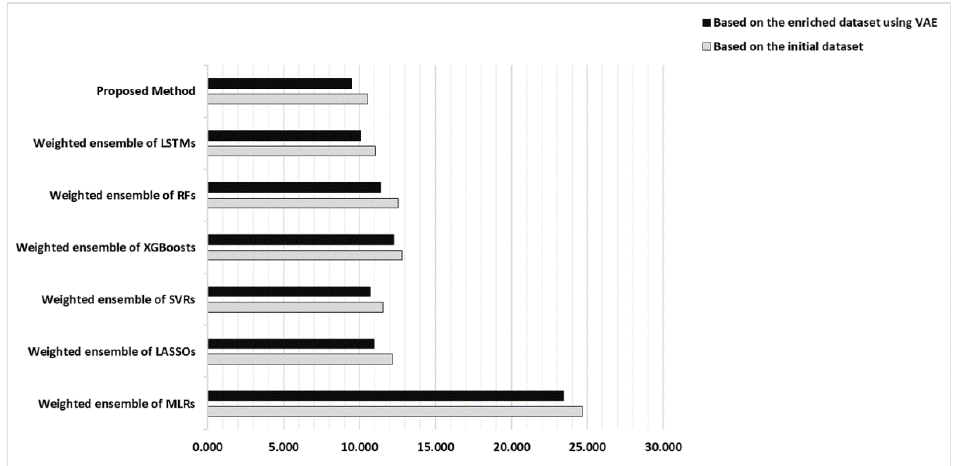
Figure 8. Comparison of MAPE results of weighted ensemble methods based on initial and VAE- based enriched datasets.